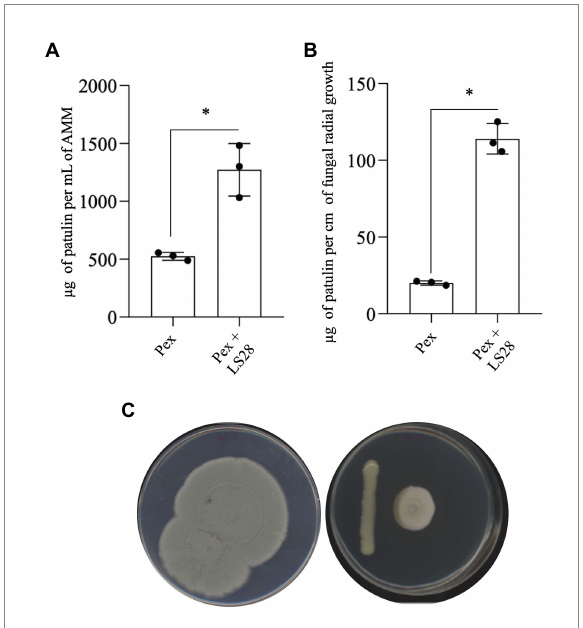
FIGURE 2 Patulin quantification in dual cultures of Penicillium expansum strain 7015 (Pex) and the biocontrol agent Papiliotrema terrestris LS28 in (A) liquid AMM ( μ g patulin ml − 1 of medium) and (B) agarized AMM ( μ g patulin cm − 1 of fungal radial growth). Patulin was extracted and quantified 7 days after the inoculation. Data are presented as mean values ± SD from three independent experiments (black dots). * p < 0.05 vs. Pex according to two- tailed, unpaired Student’s t -test.